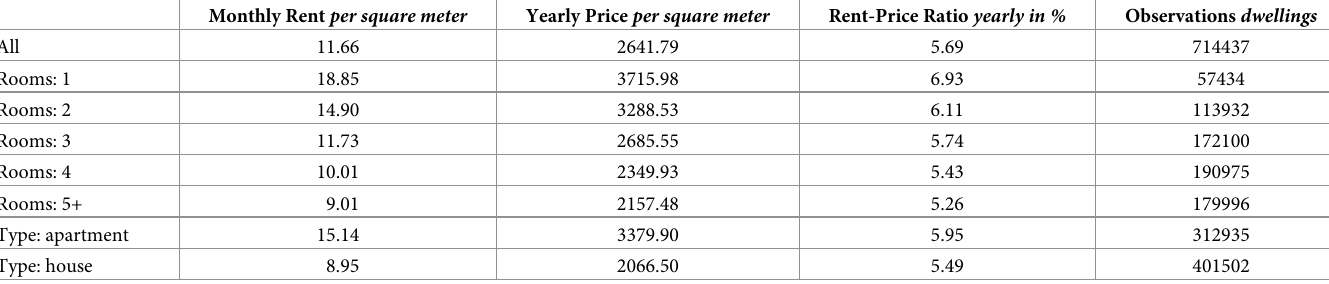
Table 7. Descriptive statistics on the transaction-level rent-price